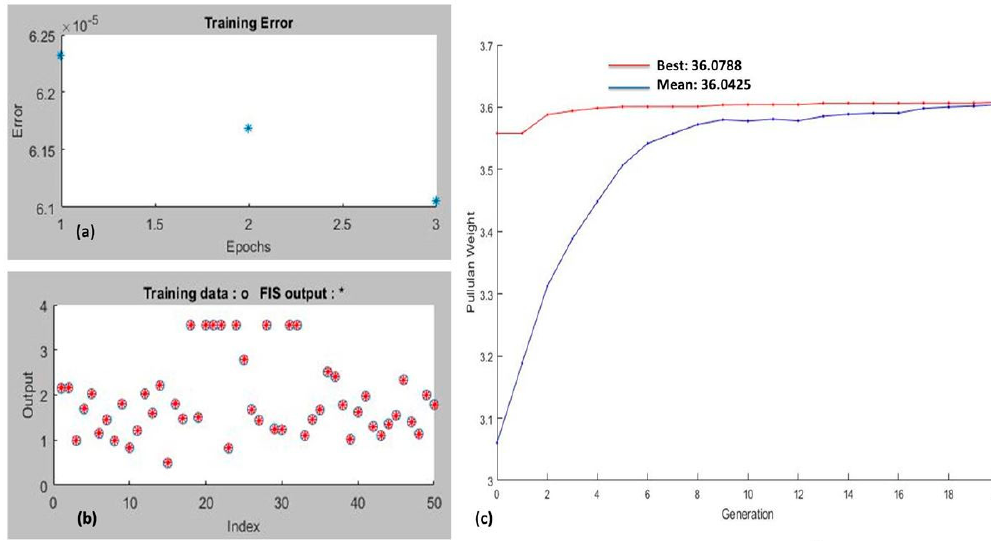
Figure 4. ( a ) Training error at three different epochs. ( b ) Training performance of FIS. ( c ) Convergence of GA–ANFIS for maximizing pullulan weight.